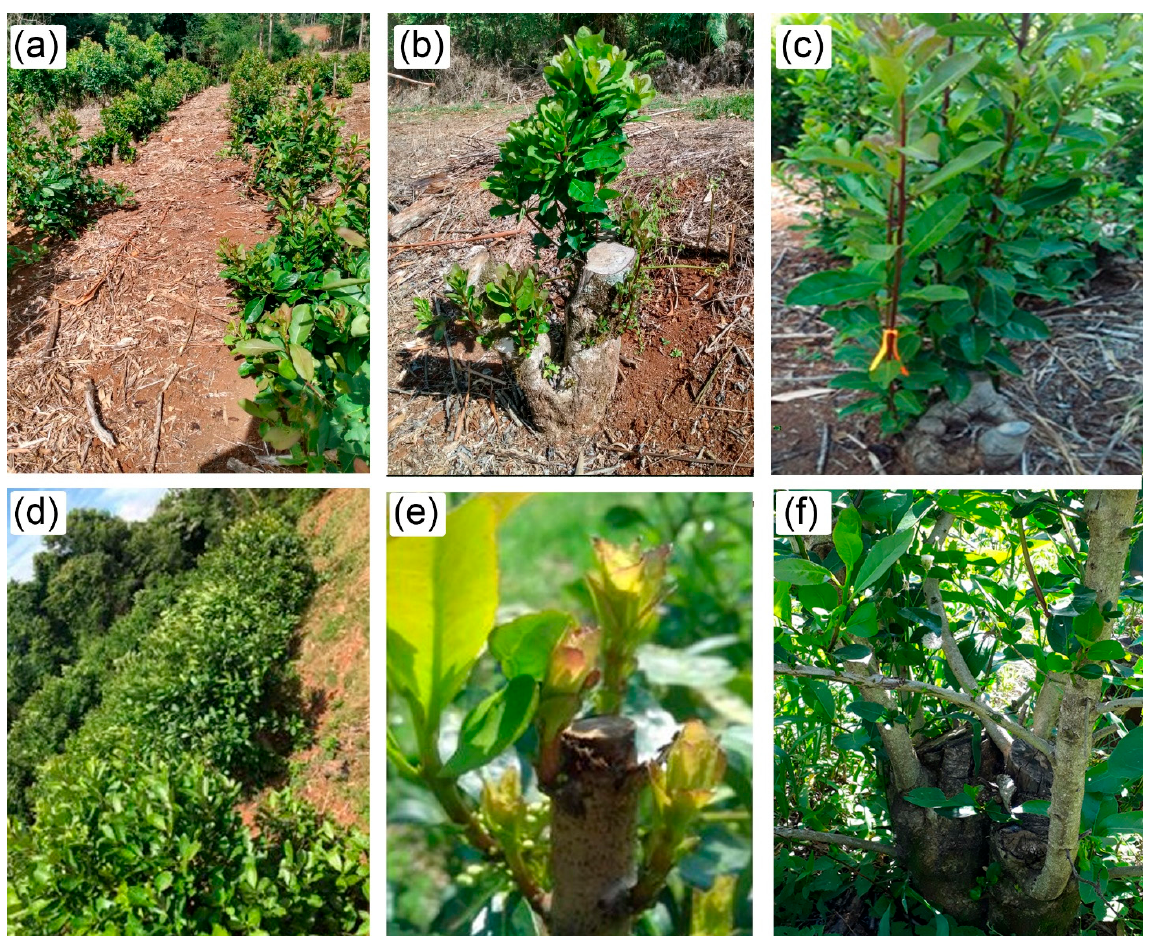
Figure 3. Monitoring of the experiment during the years 2019 ( a – c ) and 2020 ( d – f ). In ( a ) is growth profile of yerba-mate plants; in ( b ) is start of primary branches emergence; and in ( c ) is follow-up of randomly selected branches; in ( d ) is morphological profile of plants in 2020; in ( e ) is new branches after pruning in 2020; and in ( f ) is detail in the plant architecture, originated from the five branches selected in the previously year.